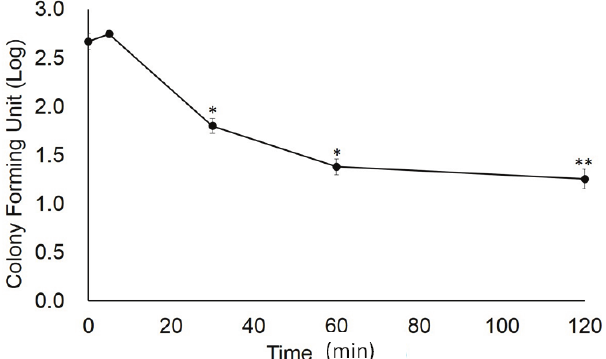
Figure 3. Antifungal effect of PHMB with sophorolipid in vitro . Values indicate log-transformed colony forming units (CFUs). CFUs of fungi within each cultured tissue sample was determined by agar plate culture. Data represent mean with SD ( n = 3).